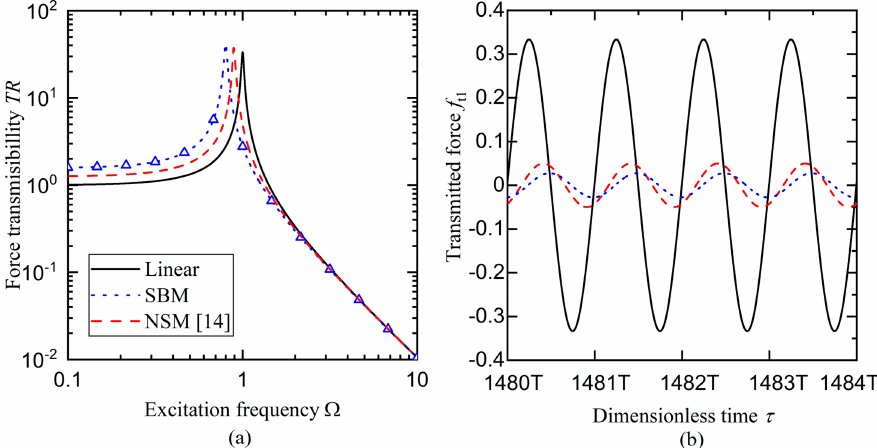
Figure 9. Force transmission performance of the SBM, the analogical NSM [14], and the linear isolator in terms of the ( a ) force transmissibility TR and ( b ) time histories of the transmitted force f t1 . Parameter values α = − 1, β = 0.36, ξ = 0.01, F 0 =